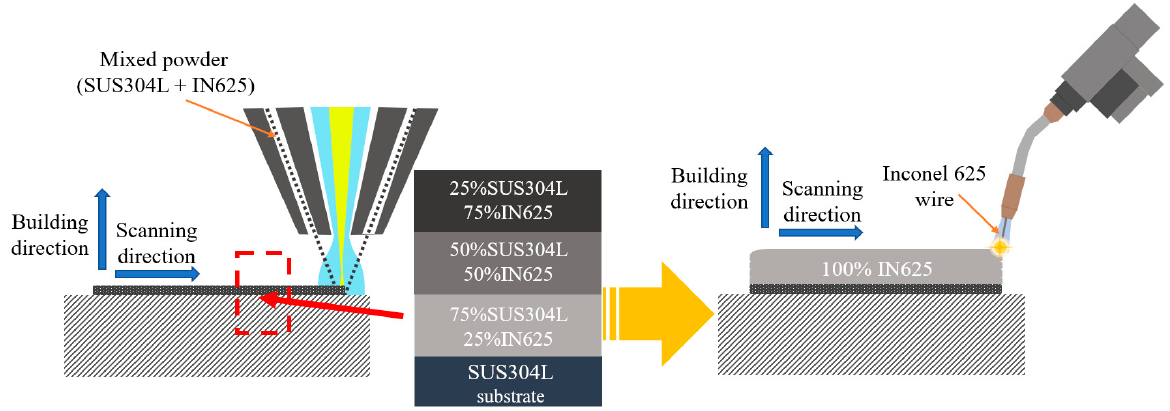
Figure 4. The schematic of the LMD-WAAM process.